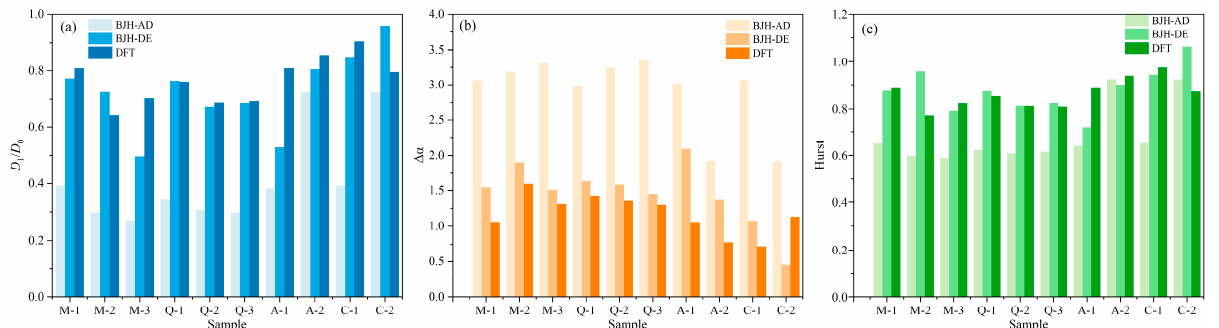
Figure 10. Statistical plots of multiple fractal parameters for different shale facies: ( a ) D 1 / D 0 ; ( b ) Δα ; ( c ) Hurst index.